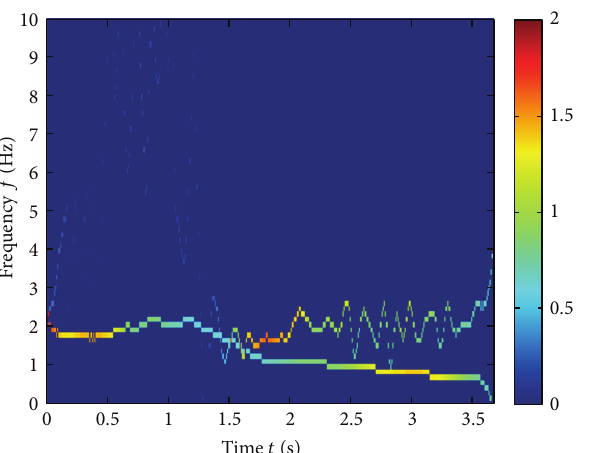
Figure 10: The axle box vibration